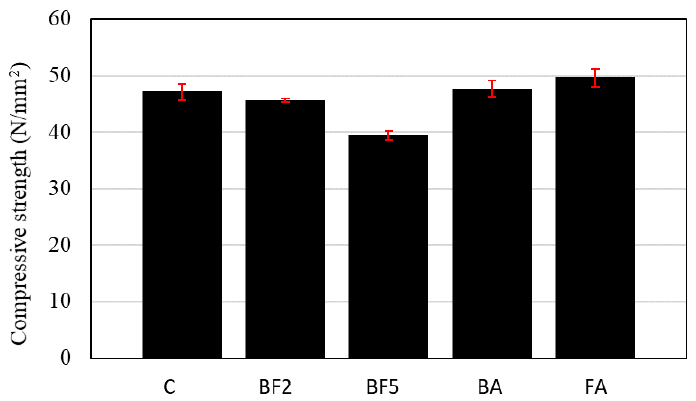
Figure 10. Compressive strength of each concrete mixture.